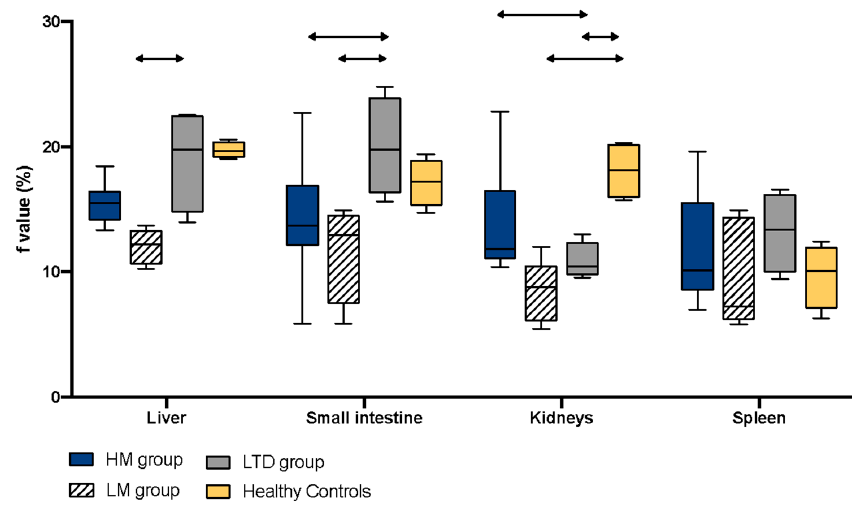
Figure 3. f value represented in abdominal organs per group. Data presented as mean, standard deviation and range. The arrows represent statistically significant difference between groups.